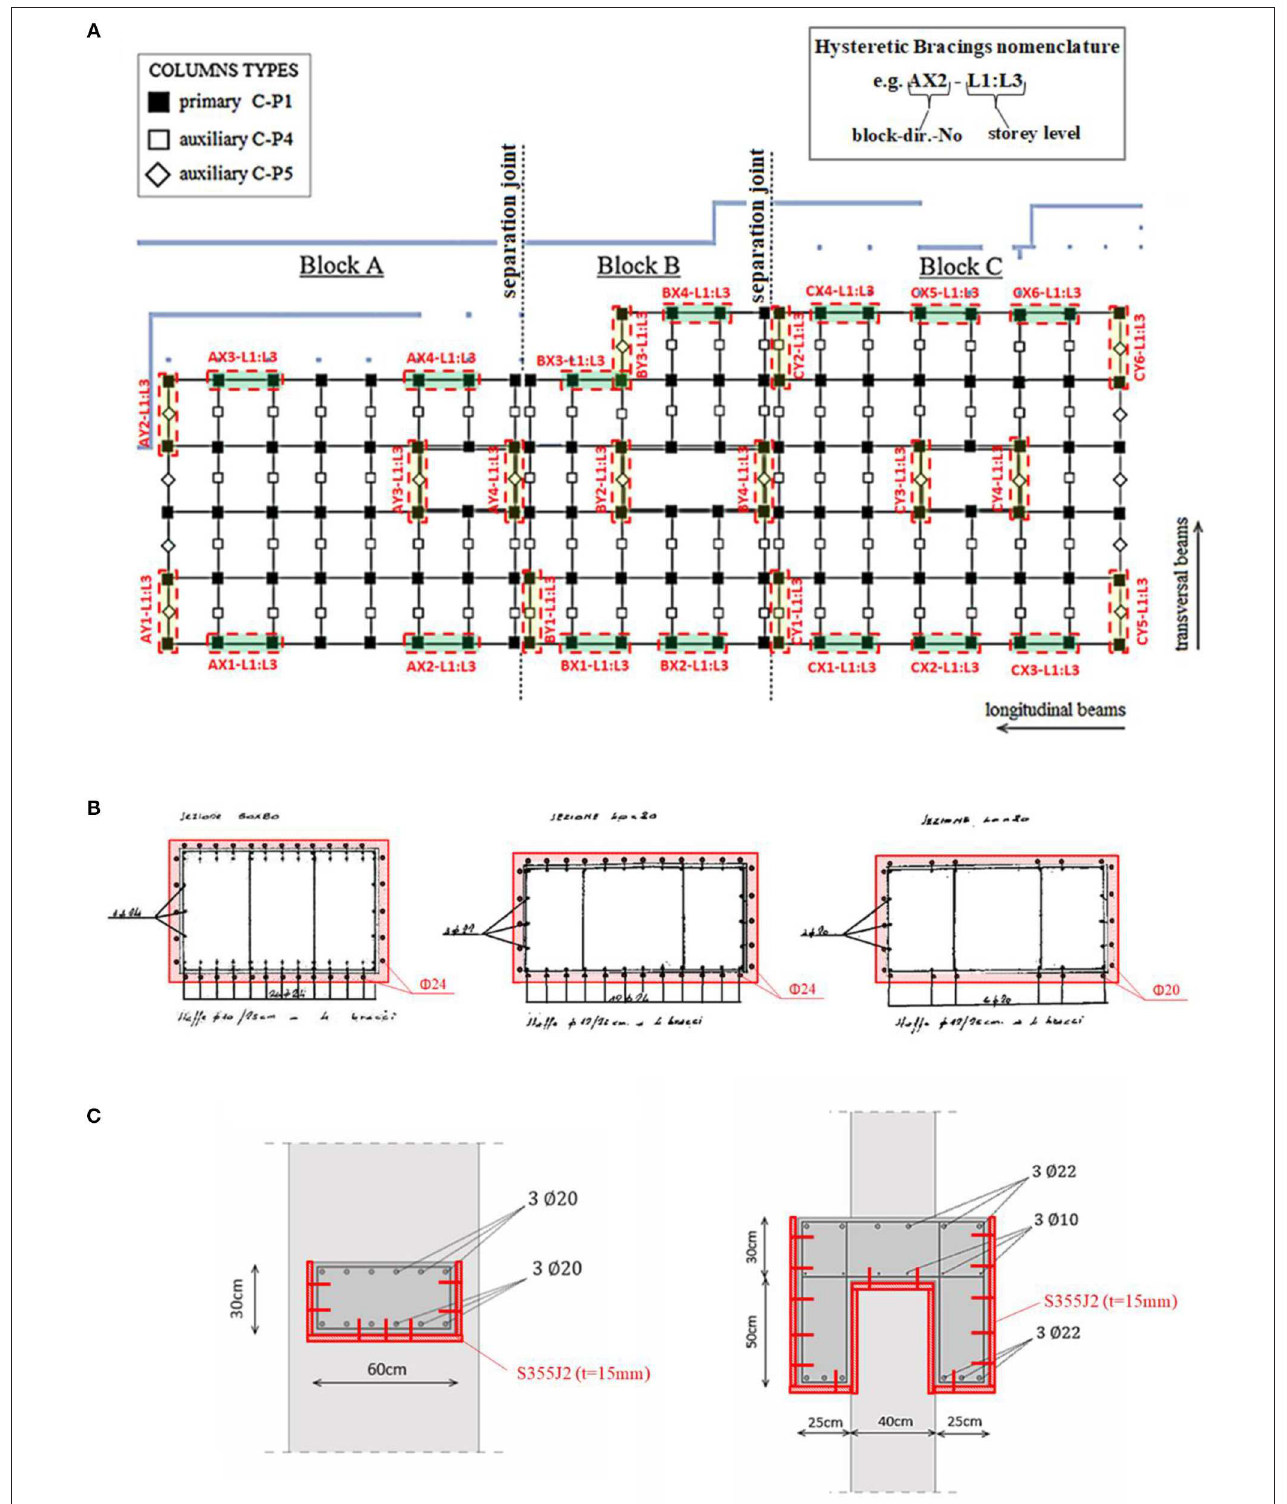
FIGURE 2 | Structural layout of the “Piastra” building. (A) Columns grid (in black) and plan arrangement of Dissipative Braces (in red-dashed). (B) Cross-section of primary columns: (left) C-P1; (center) C-P2; (right) C-P3. (C) Cross-section of beams in the longitudinal (left) and transversal (right) directions. Proposed strengthening is drafted in red lines, superimposed to the original layout in black/gray.